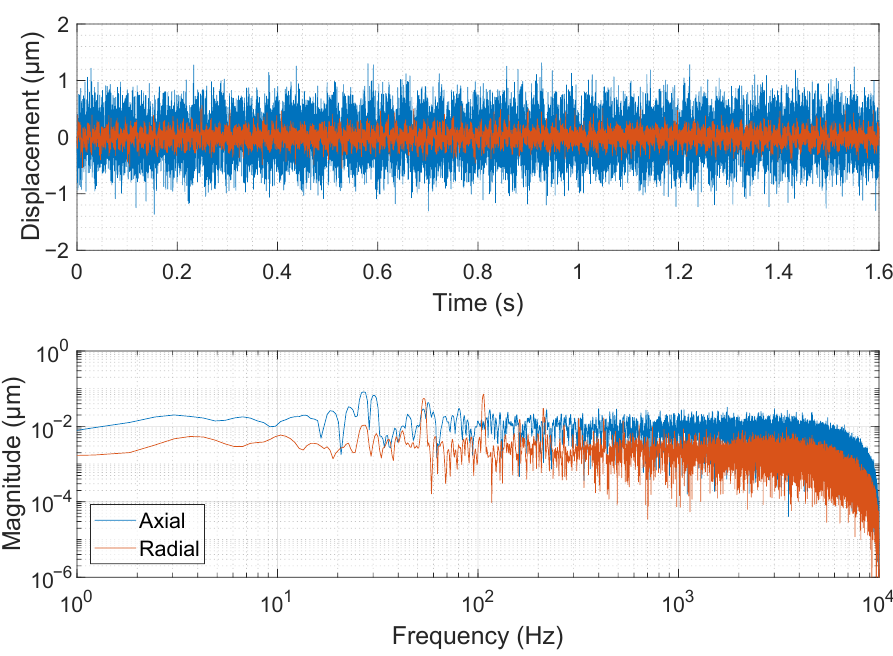
Figure 10. Measured noise level when the machine’s rotor is lying statically on the safety bearings. Frequency domain fast Fourier transform (FFT) consists of 32,768 samples at 20 kHz sampling frequency.